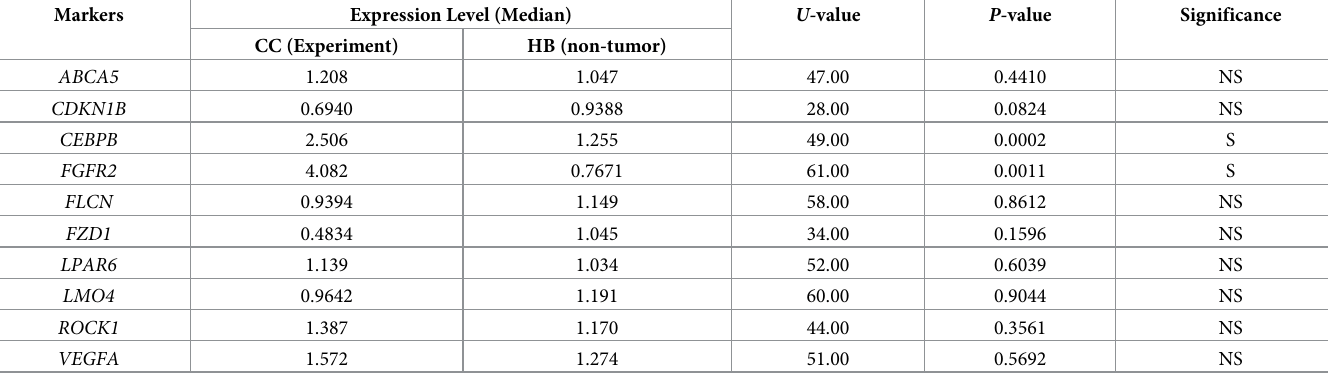
Table 1. Mann Whitney U test on the expression of DE genes in CC and HB